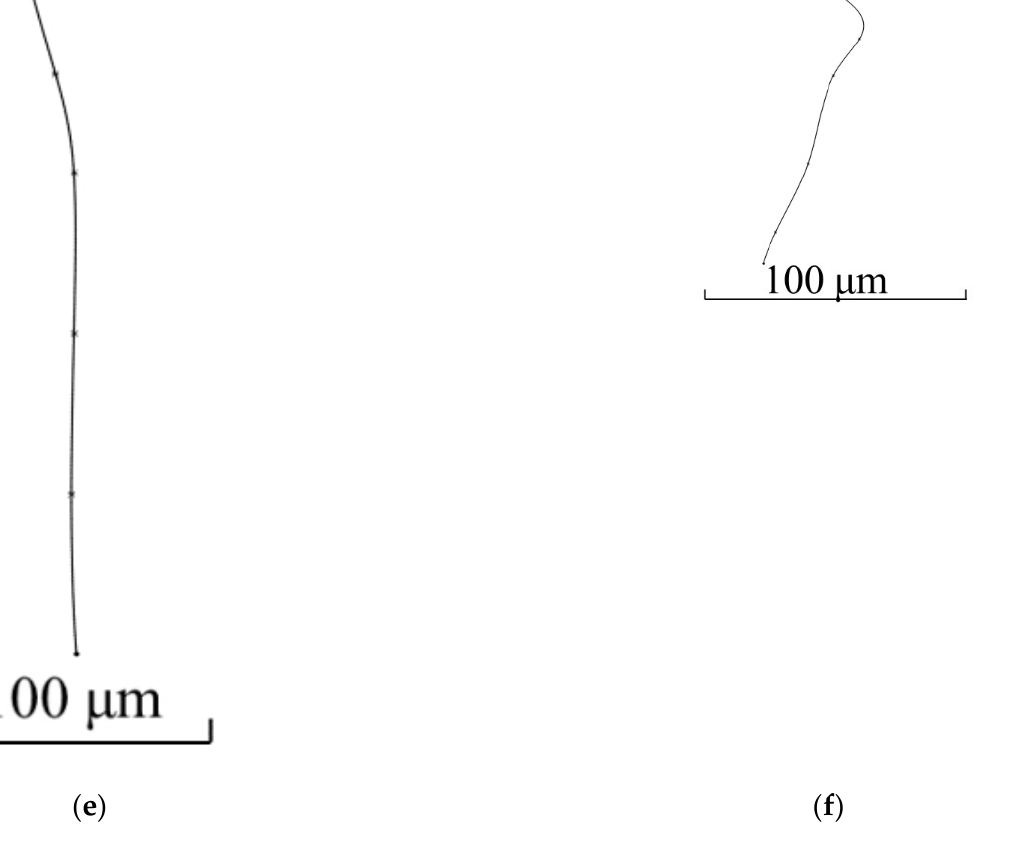
Figure 10. Spline passing through the cross-sections’ centers of the 3D model of grain before screw rolling ( a , c , e ) and spline passing through the cross-sections’ centers of the 3D model of grain after screw rolling ( b , d , f ): side views ( a , b ); front views ( c , d ); top views ( e , f ).